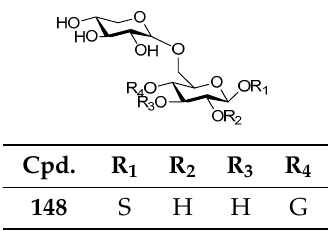
Figure 12. Structures of compounds 145 – 147 .